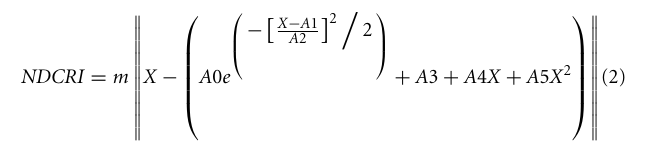
FIGURE 5 | Sequence of line plots describing (A) the local scale measurement of hyperspectral reflectance data along with (B) the spectral sensitivity of the regional scale sensor